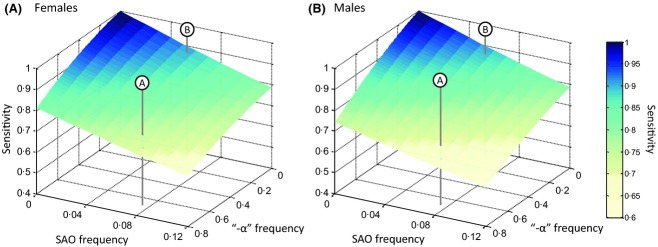
The combined impact of SAO, alpha thalassaemia frequency and G6PD deficiency on the sensitivity of one tube osmotic fragility tests for beta thalassaemia. The surfaces illustrate how the sensitivities of one tube osmotic fragility tests for beta thalassaemia change in males and females with changing frequencies of alpha thalassaemia (the ‘−α’ deletion) and the mutation responsible for Southeast Asian Ovalocytosis (SAO). g1 = 0·95, g2 = 0·75, g4 = 0·5, and g5 = 0. In both panels the population frequency of G6PD deficiency is 0.13. Marker ‘A’ indicates the maximum SAO and ‘−α’ frequencies that have been reported from the Northern coast of Papua New Guinea. Marker ‘B’ indicates the SAO frequency reported from Sumba Island, Indonesia, and a plausible Indonesian alpha thalassaemia frequency.